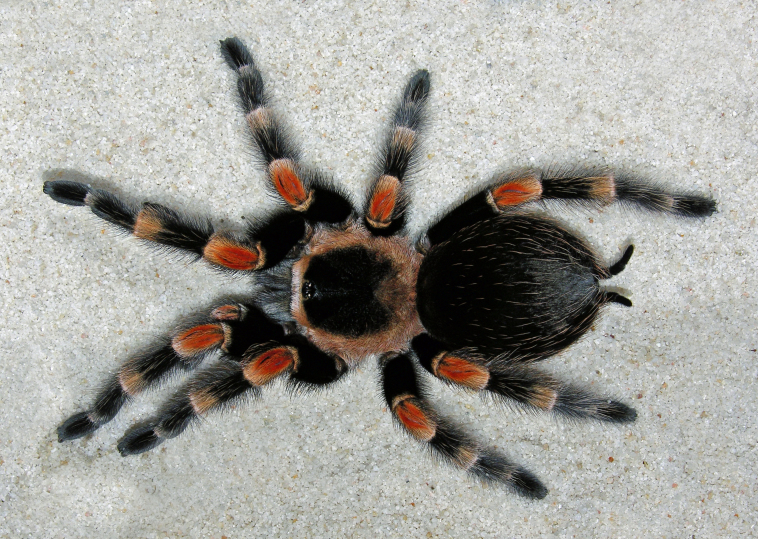
Brachypelma
hamorii Tesmoignt, Cleton & Verdez, 1997 female near Manzanillo, Colima state, Mexico. Photo: Rick C. West.